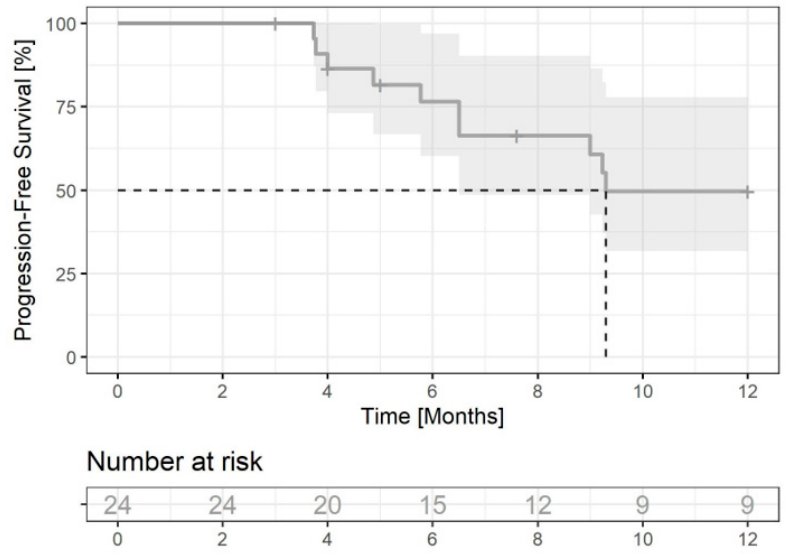
Figure 2. PFS of all studied patients (n = 24). The dashed line indicates median PFS, (progression-free survival) grey field indicates 95% CI.